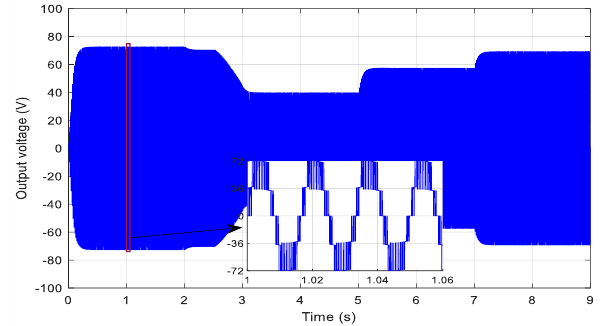
Figure 13. SPUC5 capacitor voltages.